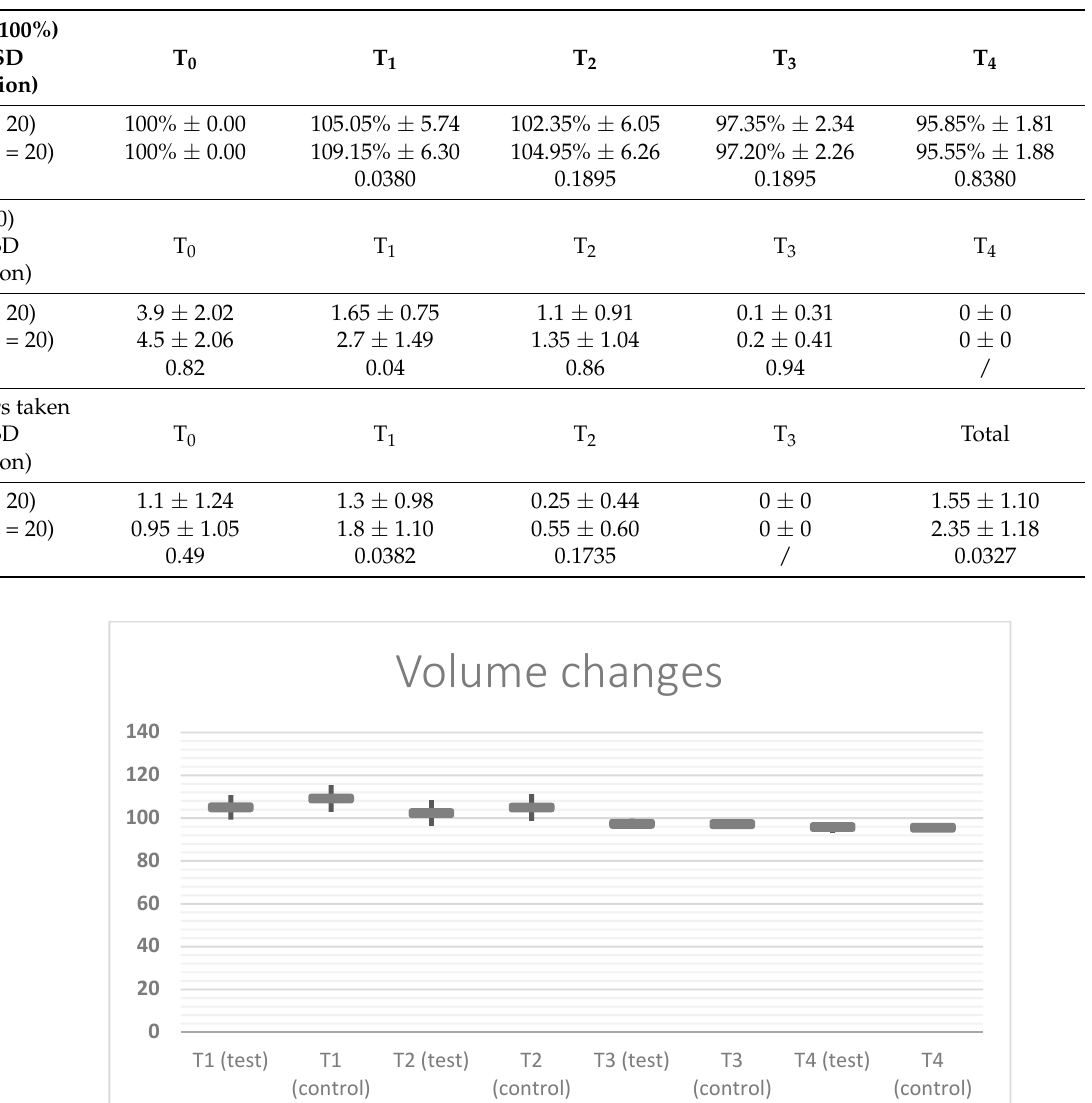
Table 2. For each group, volume (baseline 100%), VAS score (0–10), and number of painkillers.